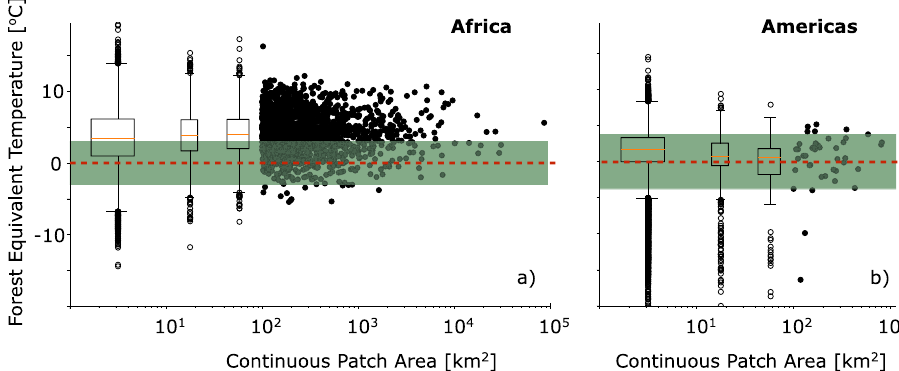
Fig. 3 Individual Patch Forest Equivalent Temperature (FET) and continuous patch area. The relationship between contiguous patch area and mean within-patch FET in Africa (left) and the Americas (right). The box plots are aggregates of small, medium, and large patches. The orange lines in the boxes show median values, boxes show the interquartile range, whiskers show the 5 th – 95 th percentiles, and open circles show the outliers. Filled black dots show patches larger than 100 km 2 . The green shading shows the standard deviation of the control points (intact forests, see Fig. 2). The red line shows the zero value (a value of zero means that the patch of silvopasture has the same temperature as intact forests at the same latitude). Table 1 Best- fi t linear regression slopes quantifying the relationship between mean within-patch mean Forest Equivalent Temperature (FET) and woody carbon